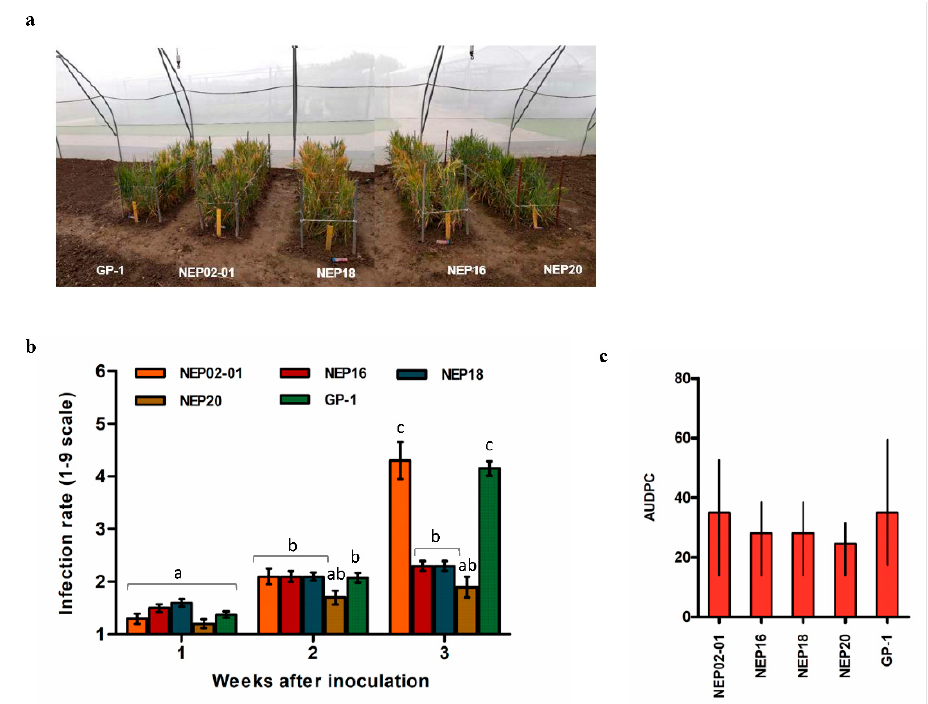
Figure 3. Semi-field analysis of transgenic barley lines overexpressing HvNEP-1 against FHB infection. ( a ) Semi-field evaluation of Fusarium -infected four T1 transgenic lines (NEP02-01, NEP16, NEP18, and NEP20) and control Golden promise (GP) plants in the semi-field plots 3 weeks after infection; ( b ) Fusarium infection level of T1 transgenic and control GP plants scored on a scale of 1–9. Values are the mean of 10 and 53 biological replicates for transgenic (NEP02-01, NEP16, NEP18, and NEP20) and GP plants, respectively. Letters on the top of the column bars indicate statistically significant di ff erences ( p = 0.05, LSD test); ( c ) AUDPC for the semi-field-grown T1 transgenic lines and control GP plants. Error bars = mean + sem. Bars refer to the median AUDPC, and the minimum and maximum values are indicated with error bars.